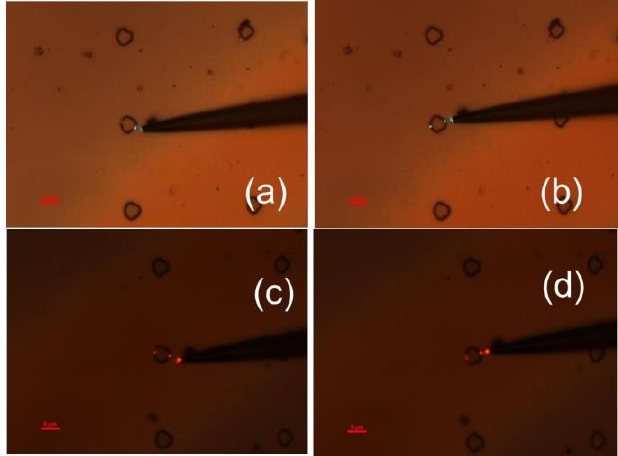
Figure 4. Experimental verification of broadband performance of the magnifying Maxwell fisheye lens. ( a , b ) Images taken at λ = 515 nm. ( c , d ) Images taken at λ = 633 nm. The scale bar length is 5 μm in all images.